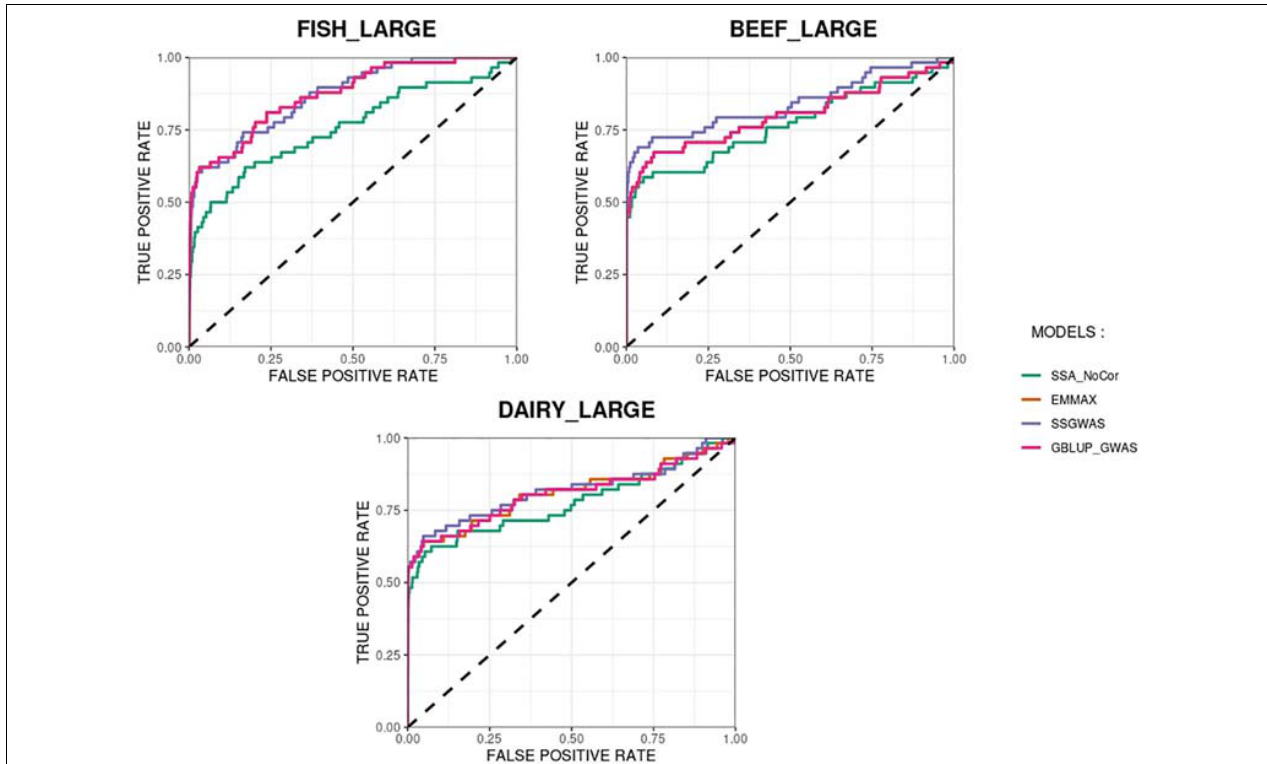
FIGURE 12 | Receiver operating characteristic (ROC) curves for GWAS results for the large populations of fish, beef cattle, dairy cattle with ten daughters per sire. The association methods used were single-SNP analysis without correction for population structure (SSA-NoCor), efficient mixed-model association expedited (EMMAX), single-step GWAS (ssGWAS), and genomic best linear unbiased prediction GWAS (GBLUP-GWAS). The dashed line has slope equal to one and null